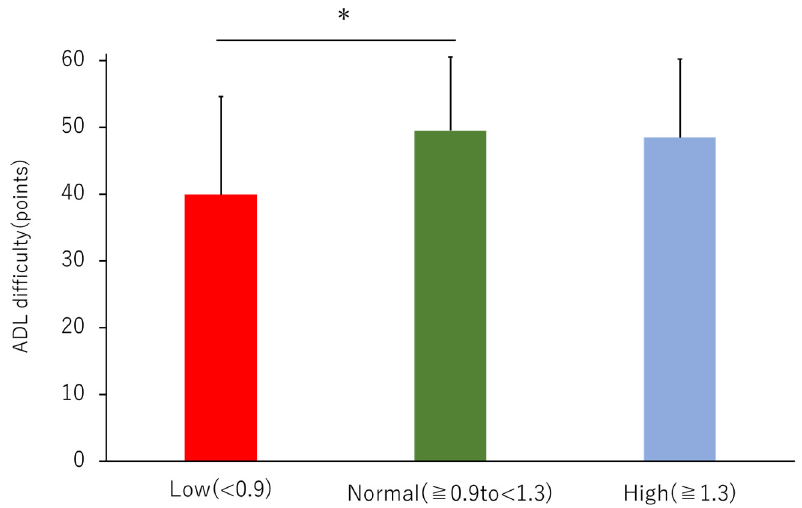
Figure 3. Comparison of activity of daily living-difficulty by ABI. Red bars indicate an ABI < 0.9, green bars indicate an ABI ≥ 0.9, but <1.3, and blue bars indicate an ABI ≥ 1.3, adjusted for age and patient characteristics to show statistically significant differences in ANCOVA. *, vs. Normal group; p < 0.05. Table 3. Patients’ GNRI, ADL difficulty, and KCL outcomes.